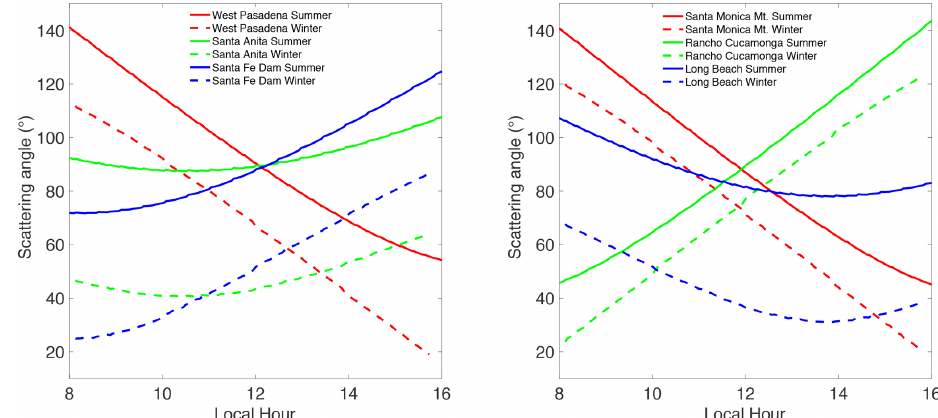
Figure 2. Diurnal change in aerosol scattering angle for six selected surface reflection points, separated into two groups. Group 1 includes points #1 Santa Anita Racetrack, #2 West Pasadena, and #3 Santa Fe Dam that are close to CLARS-FTS; group 2 includes #15 Santa Monica Mt., #17 Rancho Cucamonga, and #19 Long Beach that are further away. Hourly scenarios from 20 June and 22 December 2013 are used to represent summer and winter solar geometries, respectively.